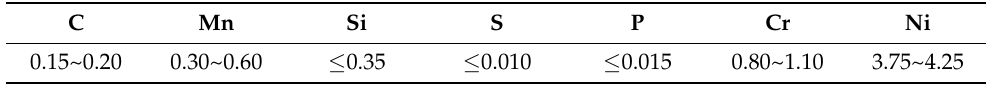
Table 2. The chemical composition of